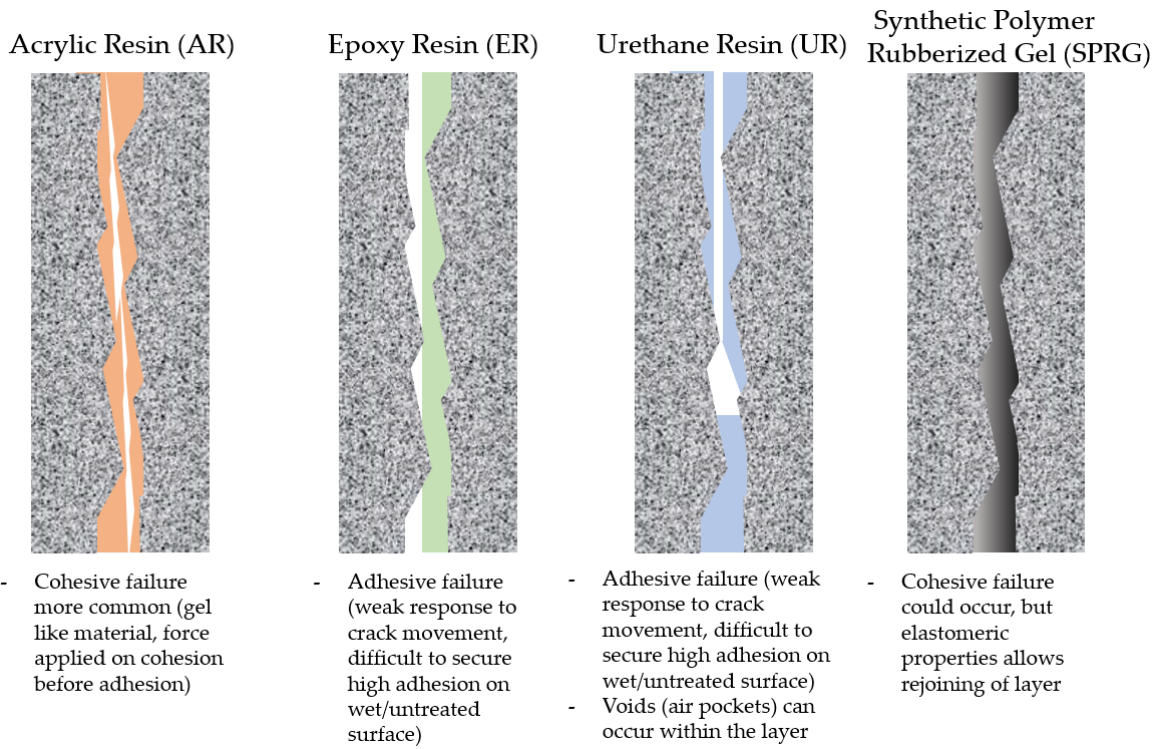
Figure 1. Failure types and mechanism of GILRM illustrated.